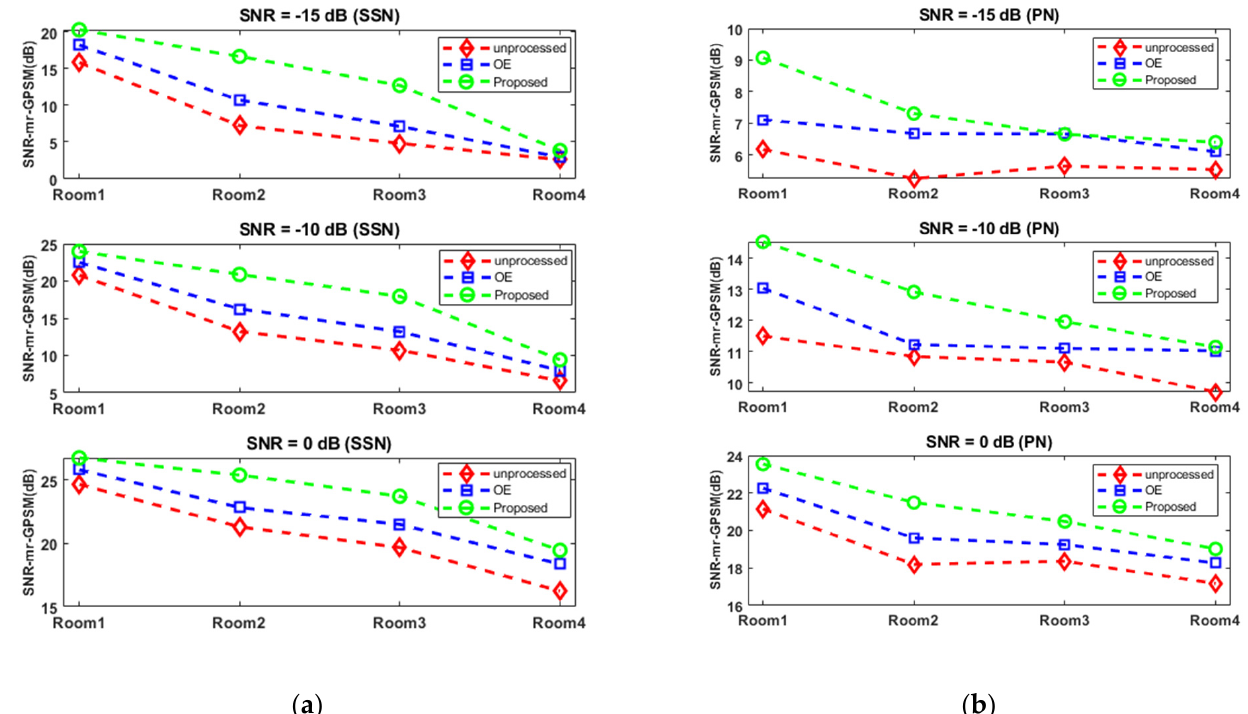
Figure 7. ( a ) The predictions of mr-GPSM for robustness evaluation scenarios in the presence of SSN. The SNR- mr-GPSM show up to 3 dB enhancement for OE and up to 10 dB improvement in comparison to the unprocessed signal in low SNR = − 15 dB; ( b ) The predictions of mr-GPSM in the presence of pink noise (PN) for three SNR values. The intelligibility scores (SNR-mr-GPSM) show about 2 dB improvement for OE and about 4 dB improvement using the proposed approach.